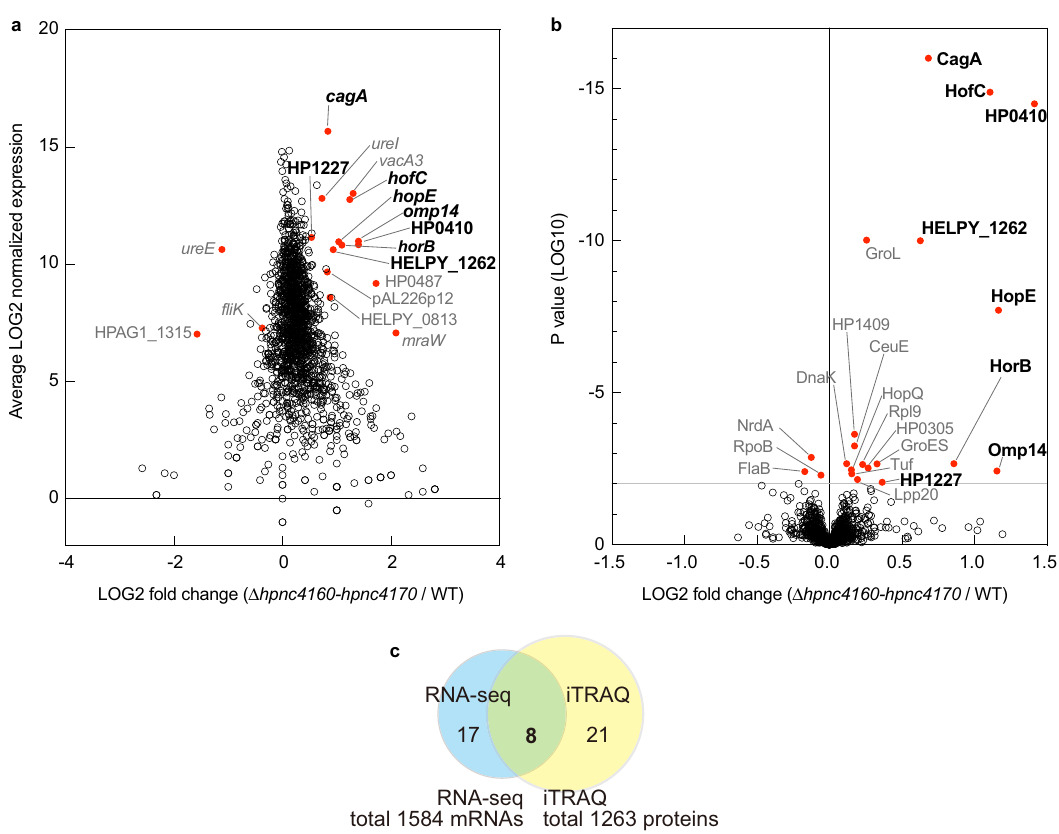
Fig. 2 HPnc4160 downregulates the expression of bacterial pathogenic factors. a MA plot of ratios [ Δ hpnc4160 - hpnc4170 / wild-type (WT) H. pylori ] versus their normalized average mRNA expression determined by RNA-sequencing (RNA-seq). Red dots, P < 0.001 by a Fisher Exact Test (two-sided). b Volcano plot of proteins quanti fi ed by isobaric tags for relative and absolute quanti fi cation analysis comparing WT and Δ hpnc4160 - hpnc4170 . Each point represents the difference in protein expression (fold-change) between the two groups plotted against the level of statistical signi fi cance. Red dots, P < 0.01 by the paired t-test (two-sided). c Venn diagram representing the number of signi fi cantly differentially expressed factors between Δ hpnc4160 - hpnc4170 and WT. Source data are provided as a Source Data fi